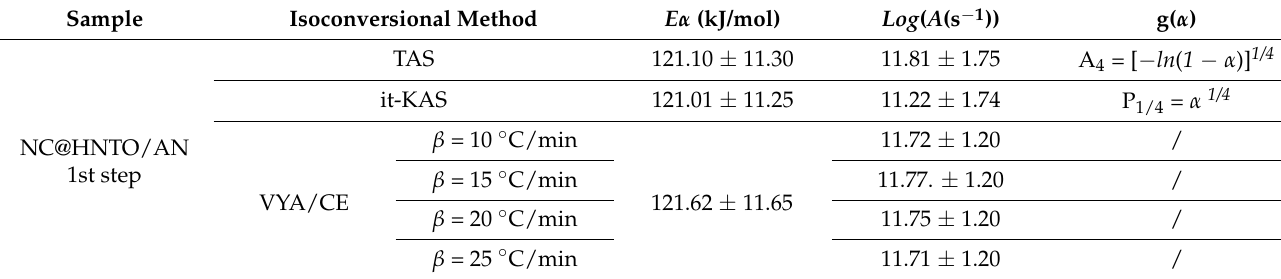
Figure 5. Activation energy progress as a function of conversion for the different stages of decomposition of ( a ) NC@HNTO/AN; ( b ) NMCC@HNTO/AN. Table 2. Kinetic parameters of the prepared energetic